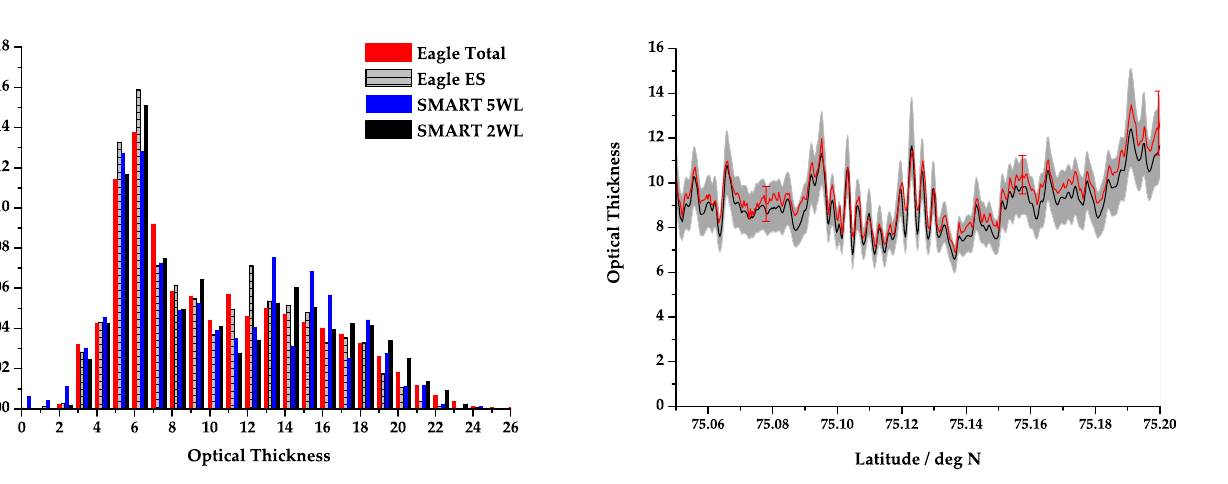
Fig. 13. Time series (excerpt) of the average cloud optical thickness in the ES pixels of the AisaEAGLE (black, with uncertainty range in grey), compared to that retrieved from the SMART-Albedometer radiance (red, with uncertainty range indicated by exemplary error